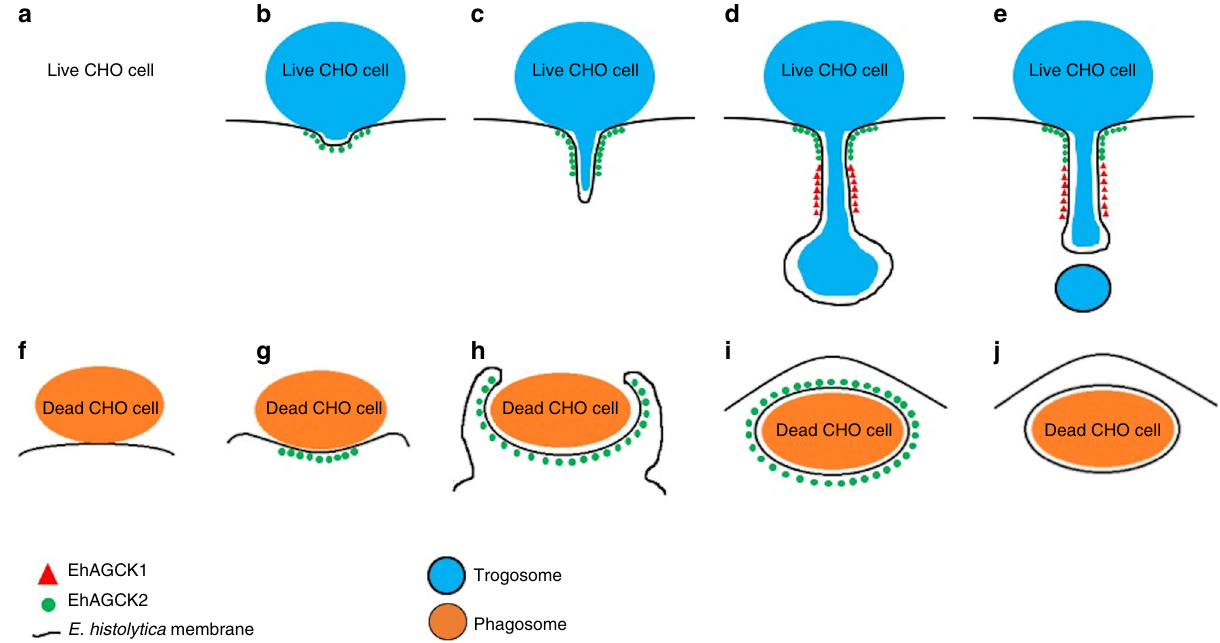
Fig. 9 Schematic presentation of localization of EhAGCK1 and EhAGCK2 during a – e trogocytosis of live CHO cells and f – j phagocytosis of dead CHO